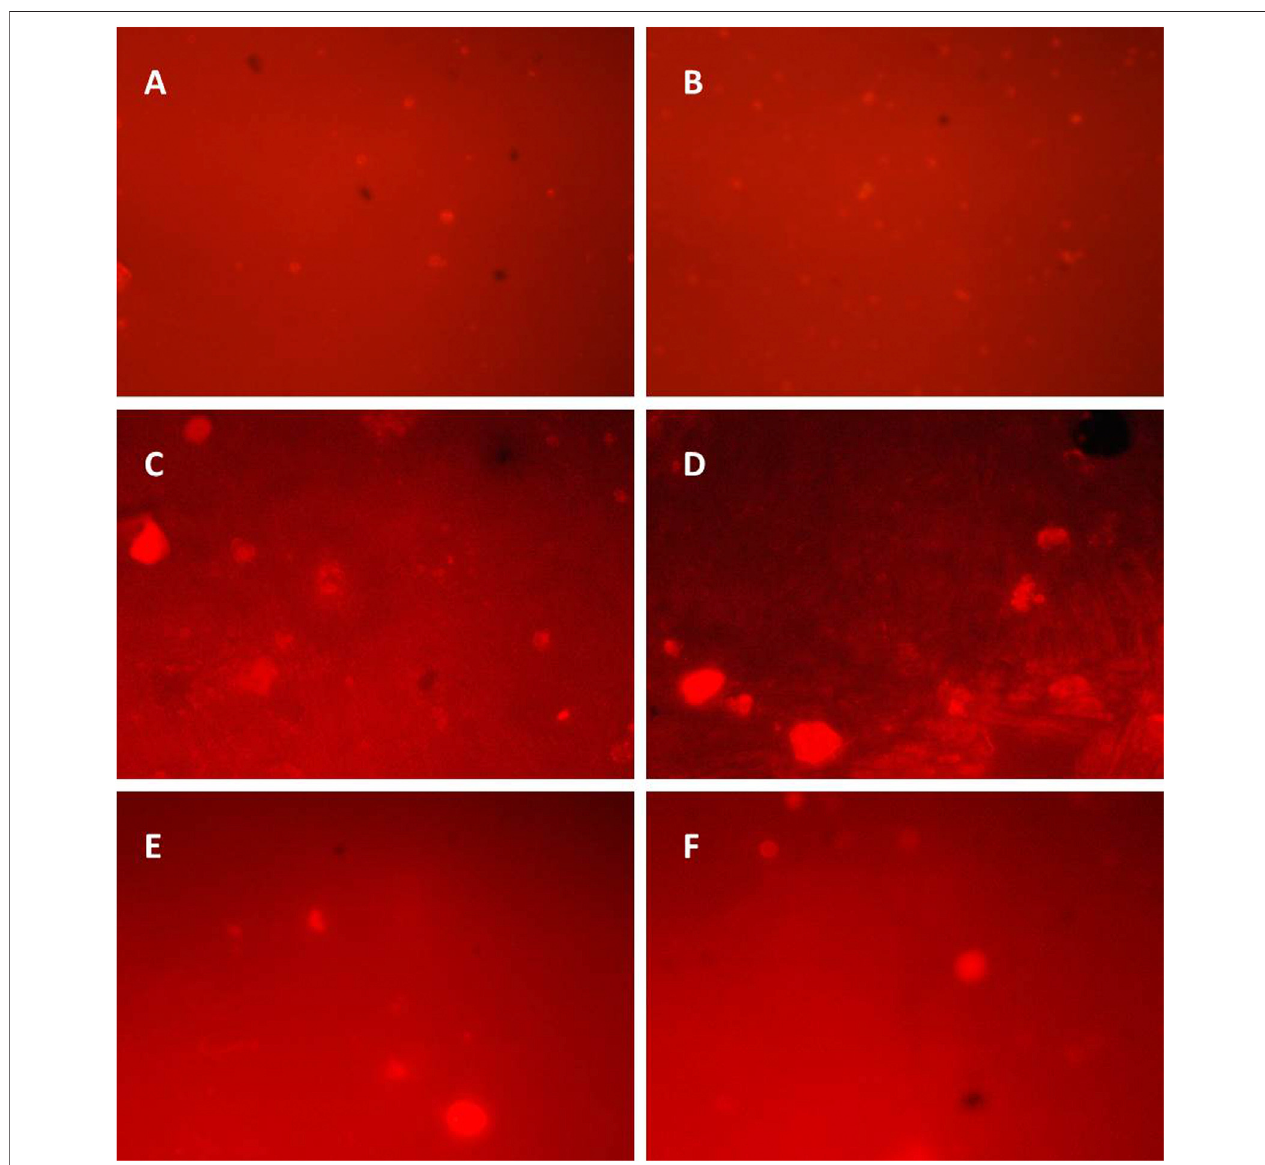
FIGURE 2 | Comet assay pro fi le for genotoxicity in Pheretima posthuma. (A) = Control; (B) = Wheat straw; (C) = Biochar; (D) = Sewage sludge; (E) = Sewage sludge 25% + Biochar 25%; (F) = Sewage sludge 25% + Wheat straw 25%.